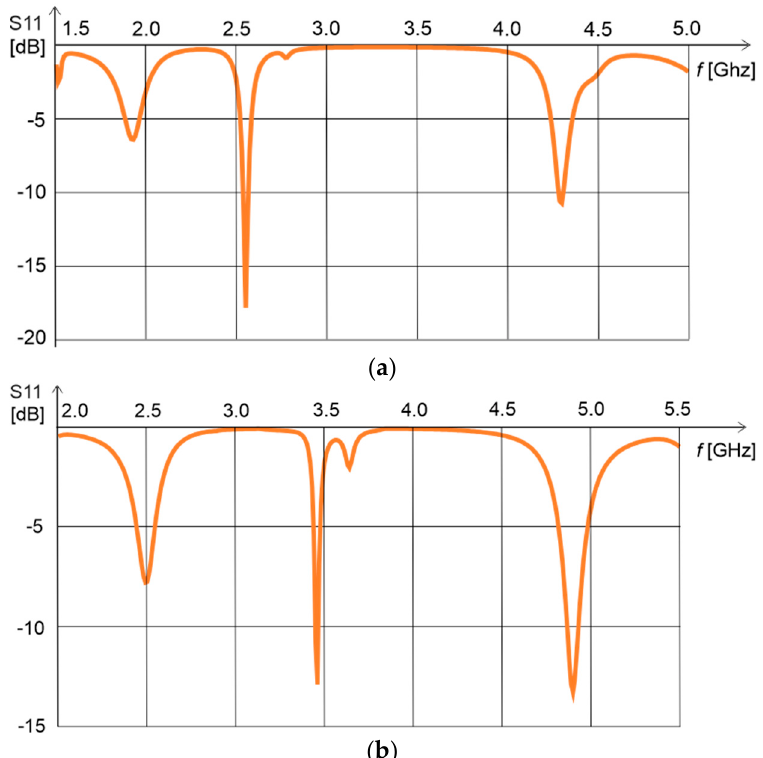
Figure 7. Impedance characteristics of the G-slot antenna: ( a ) initial model, ( b ) optimized